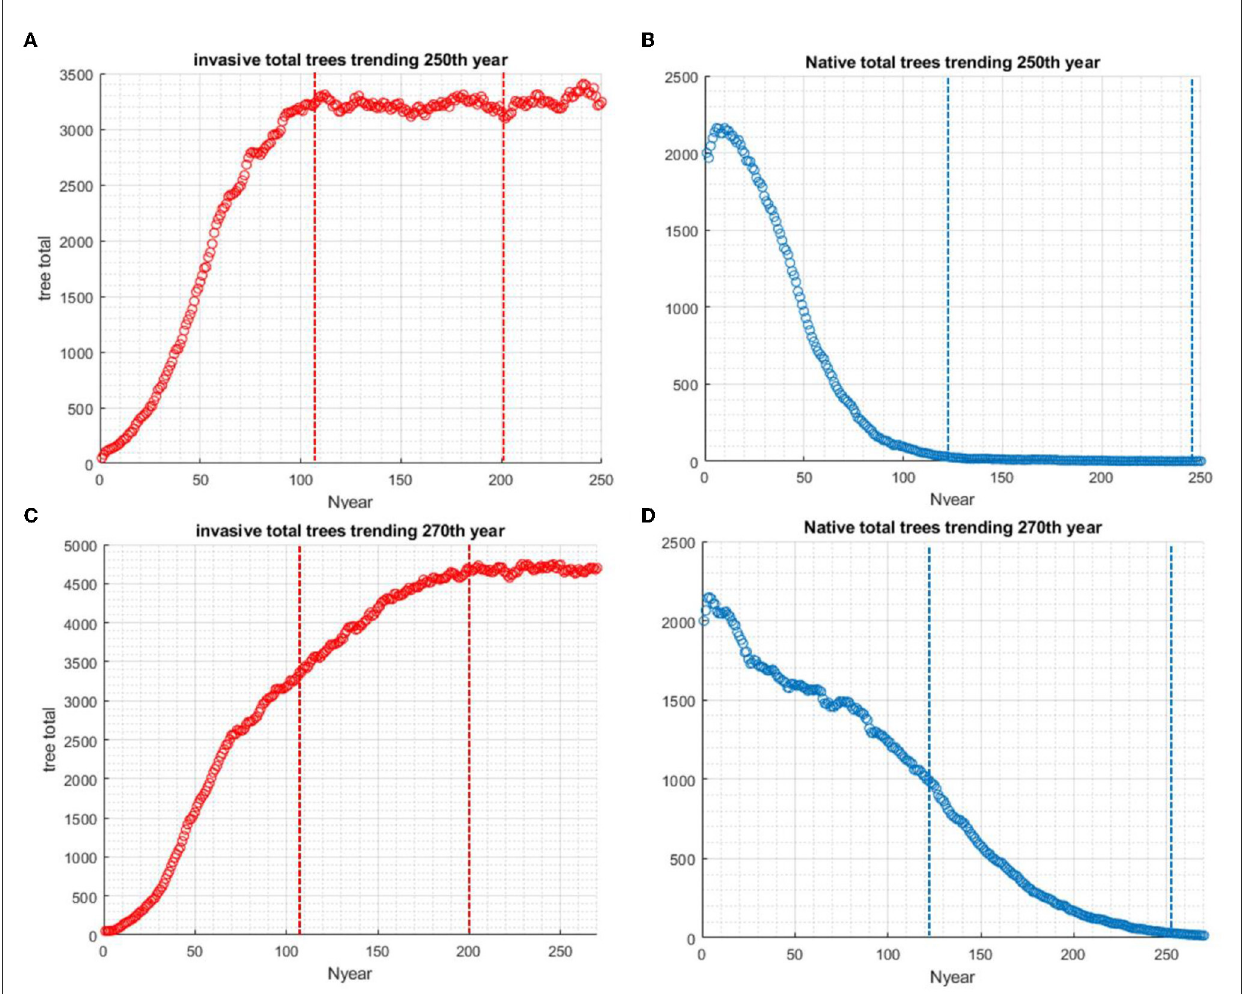
FIGURE3 The presence of standing dead introduces a delay in the invasive species reaching carrying capacity. This also delays the native species from going to extinction. Scenario 1: (A) Without standing dead in the system, the population of invasive species takes approximately 100 years to reach carrying capacity. (B) Without standing dead in the system, the population decline of native species in 100 years. Scenario 2: (C) With standing dead in the system, the total population, including standing dead, of invasive species takes nearly 250 years to reach carrying capacity. (D) With standing dead in the system, the population decline of native species to extinction takes nearly 250